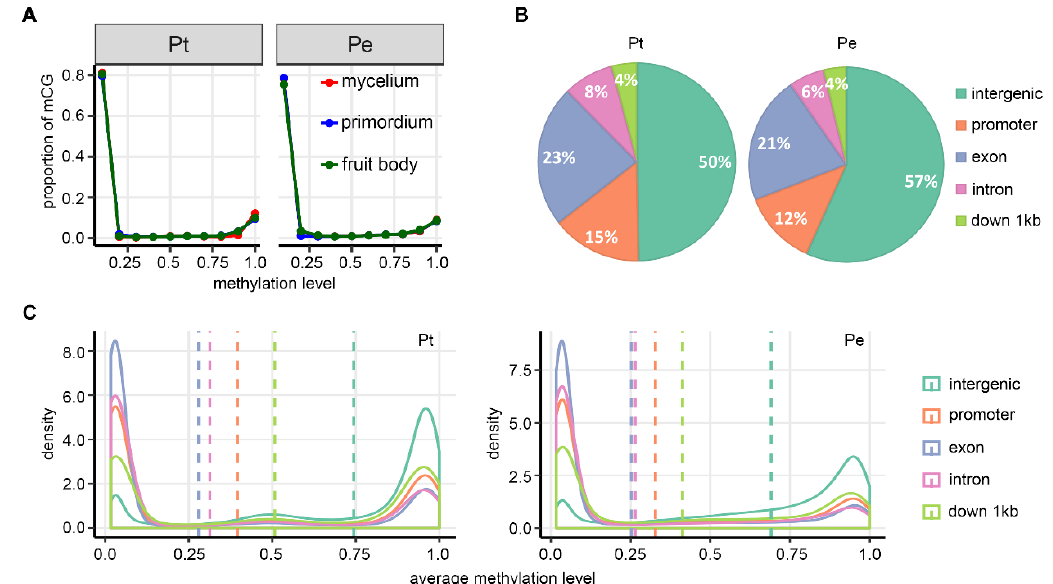
Figure 1. Landscape of DNA methylation in the two mushroom species, Pleurotus tuoliensis (designated Pt) and P. eryngii var. eryngii (designated Pe). ( A ) Distribution of DNA methylation levels of all covered CG sites (each having at least five reads) in all three tissues, mycelium, primordium and fruit body, in Pt and Pe. ( B ) Distribution of methylated CG sites (mCGs), in different categories of genomic features, intergenic, promoter, exon and down-1kb, in Pt and Pe. ( C ) Density of mCG levels among the three tissues belonging to different categories of genomic features in Pt and Pe. Dashed lines denote the average methylation levels of different genomic features in each species.